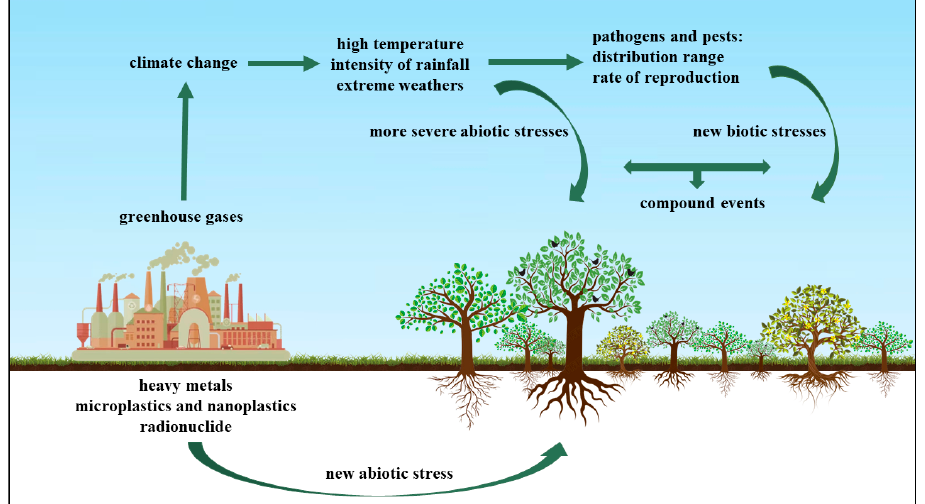
Figure 1. This picture shows the impact of human activities on climate change and new stresses. Climate change will affect temperature, intensify of rainfall and extreme weather, and environmental change will further affect the distribution range and reproduction rate of pathogens and pests. There may also be multiple abiotic stresses simultaneous compound events or biotic and abiotic stress simultaneous compound events.